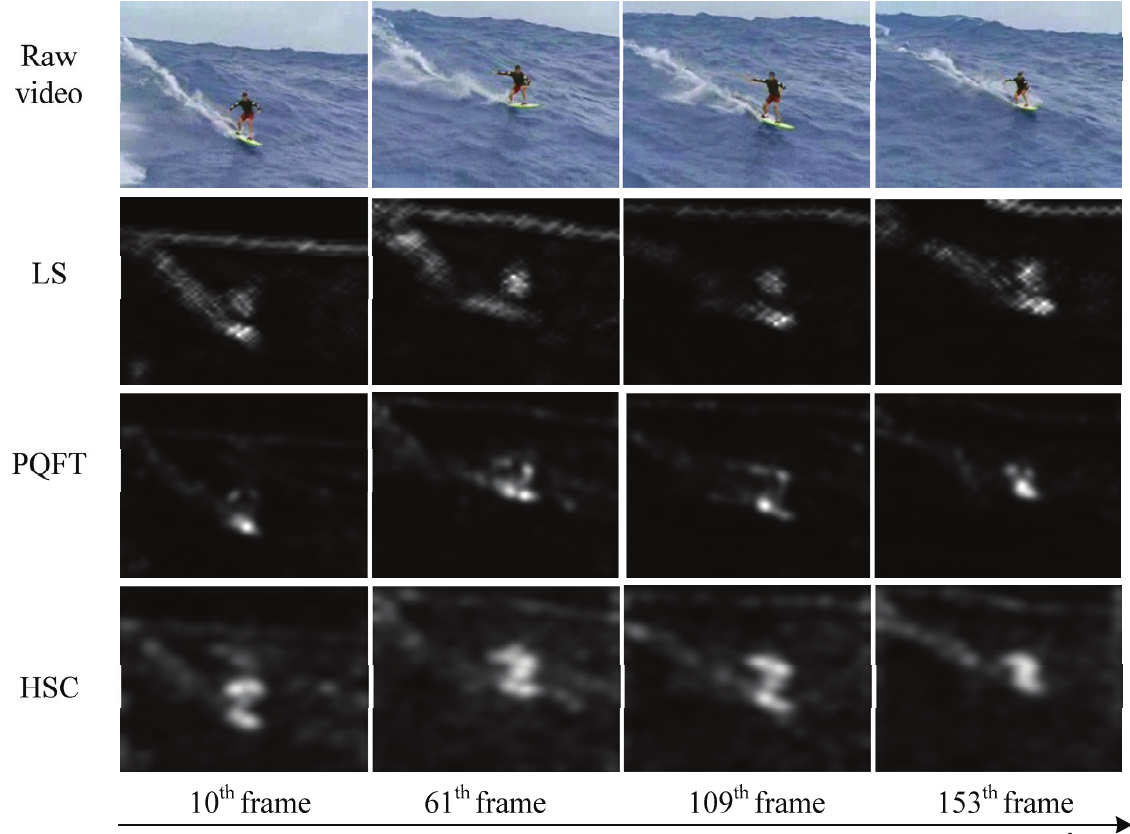
Figure 8. Comparison of two methods of spatio-temporal saliency maps in video sequences (dynamic background). The first row is the raw video [1]; the second to fourth row